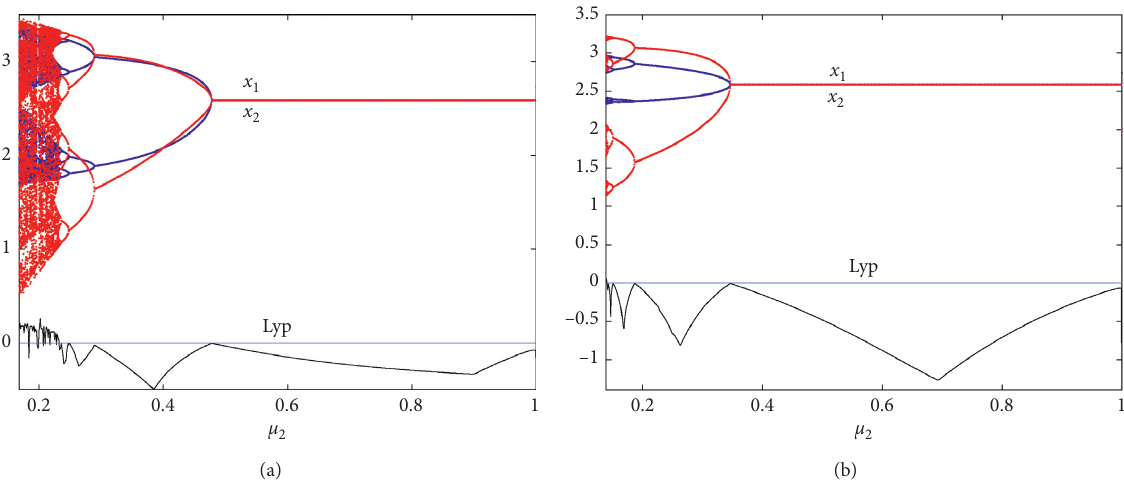
Figure 8: The bifurcation and the largest Lyapunov exponent of system (33) with respect to the parameter μ